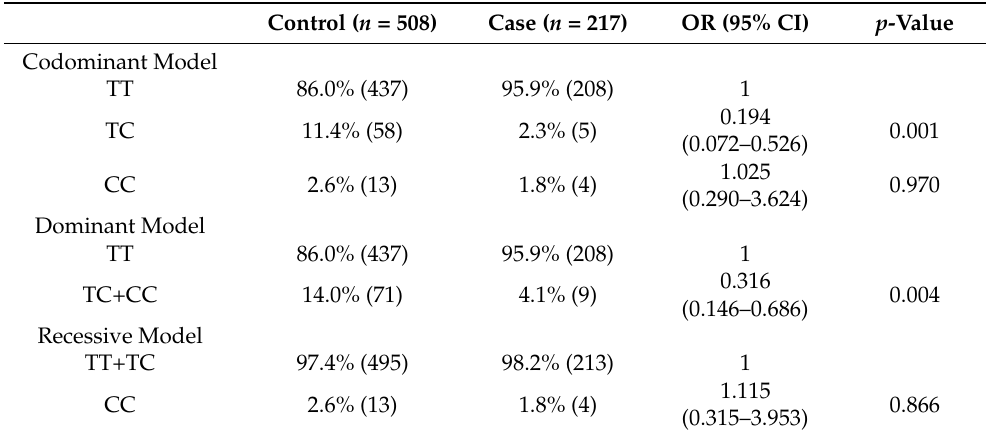
Table 8. Logistic regression analysis of the association of LPL rs294 with CHD adjusting for age and sex in 725 Kuwaitis.